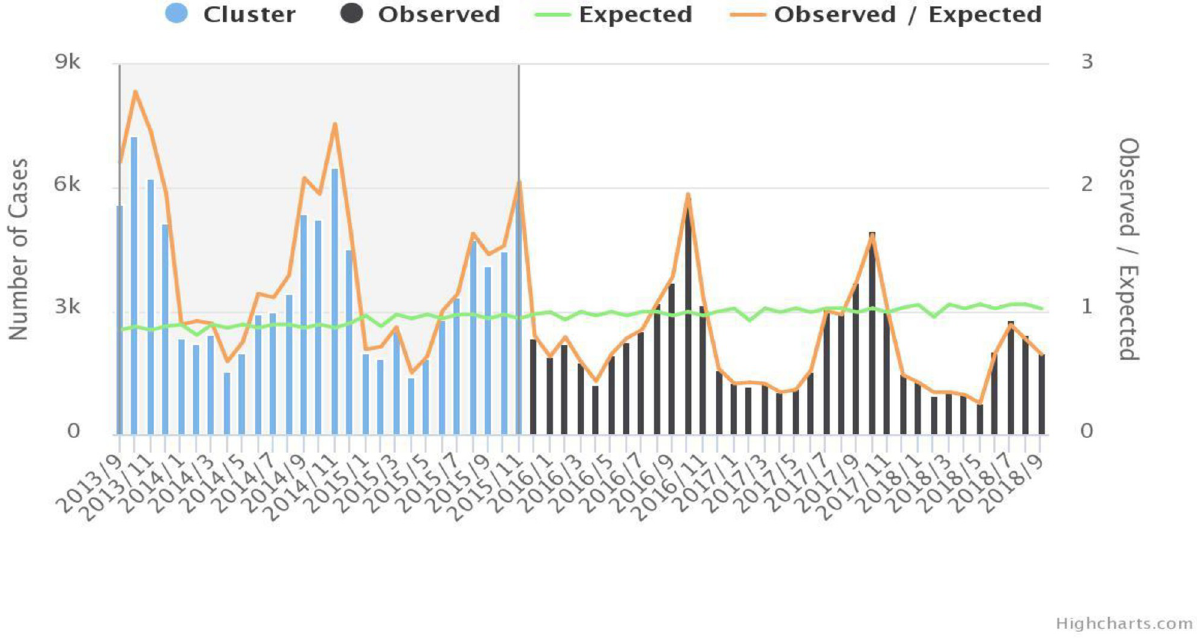
Fig 7. Purely temporal clusters of malaria cases in the study areas between 2013/09 and